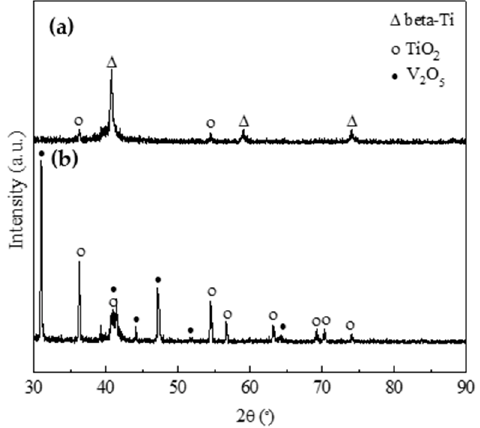
Figure 7. X ‐ ray diffraction profiles of worn surfaces in TF550 alloy after wearing at high temperatures. ( a ) 873 K and ( b ) 1073 K.